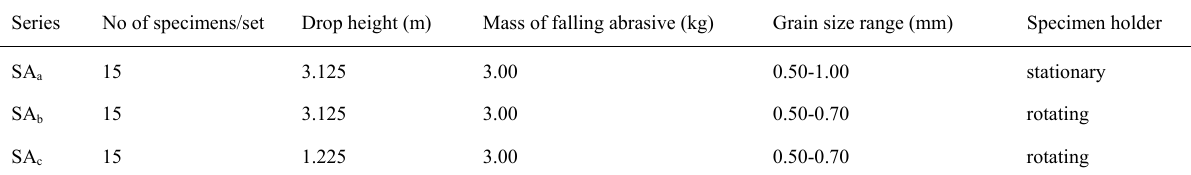
Table 2: Sand abraded (SA) series